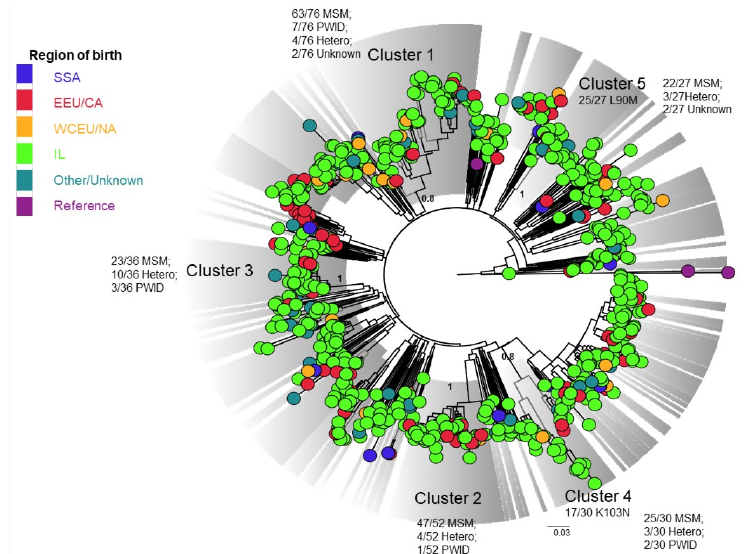
Figure 3. Phylogenetic analysis of subtype B sequences, N = 740. A phylogenetic tree of the pol region of subtype B sequences from 740 HIV-1 patients using the maximum likelihood (ML) with GTR + G + I model is shown. Included are three reference sequences (Table S1). The tree was visualized in Fig Tree version 1.4.4. Clusters (bootstrap values > 0.7) are colored in grey. Countries of origin are colored as follows: SSA (Sub-Saharan Africa) in navy blue; EEU/CA (Eastern Europe and Central Asia) in red; WCEU/NA (Western and Central Europe and North America) in orange; IL (Israel) in light green; other/unknown birthplace in turquoise; reference sequences in purple. PWID—people who use injection drug; MSM—men who have sex with men; HETERO— heterosexual contacts.